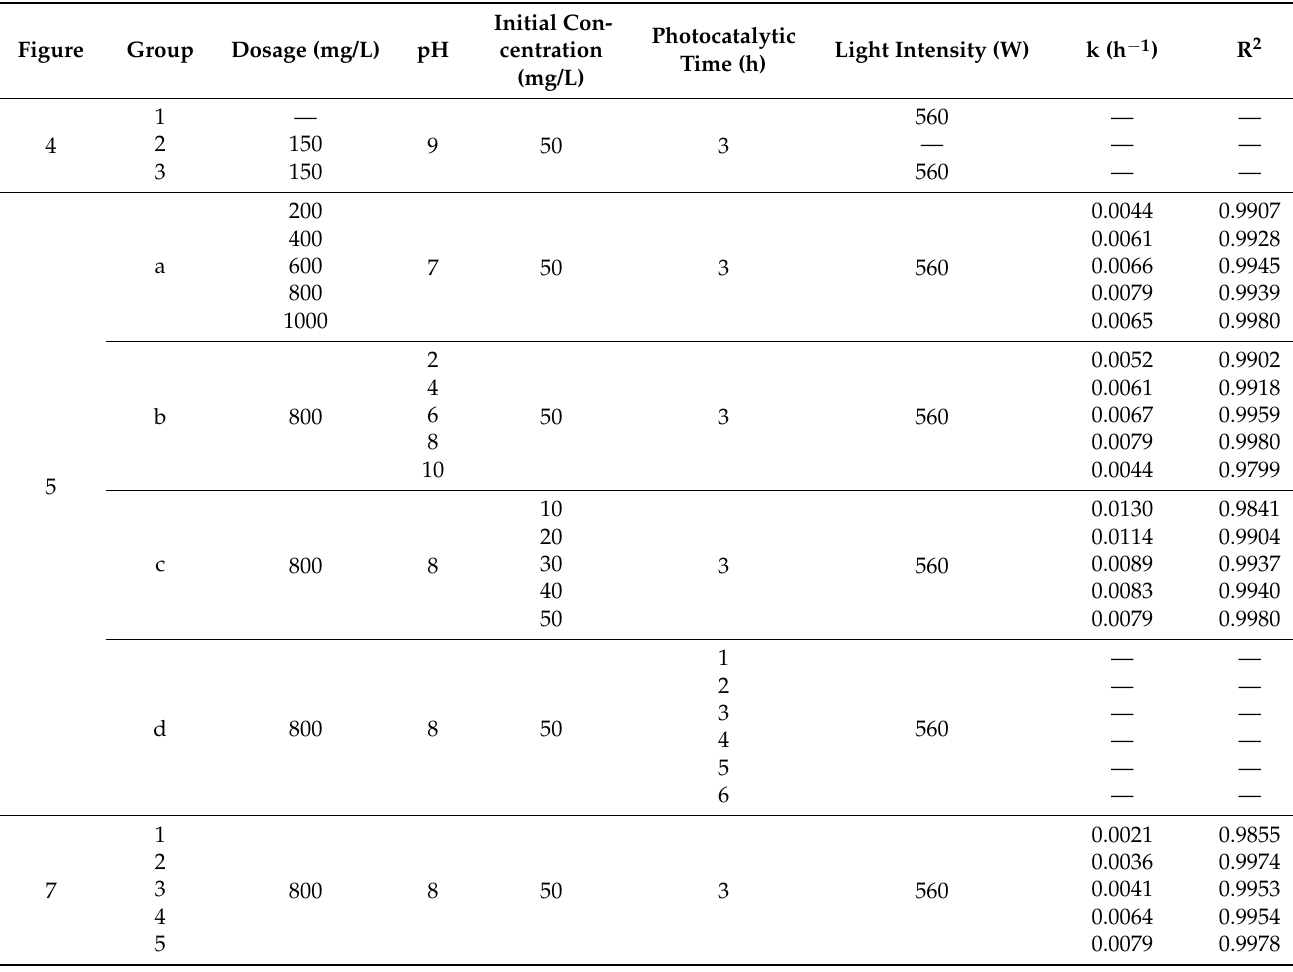
Table 1. List of experimental reaction control conditions (temperature 35 ◦ C).